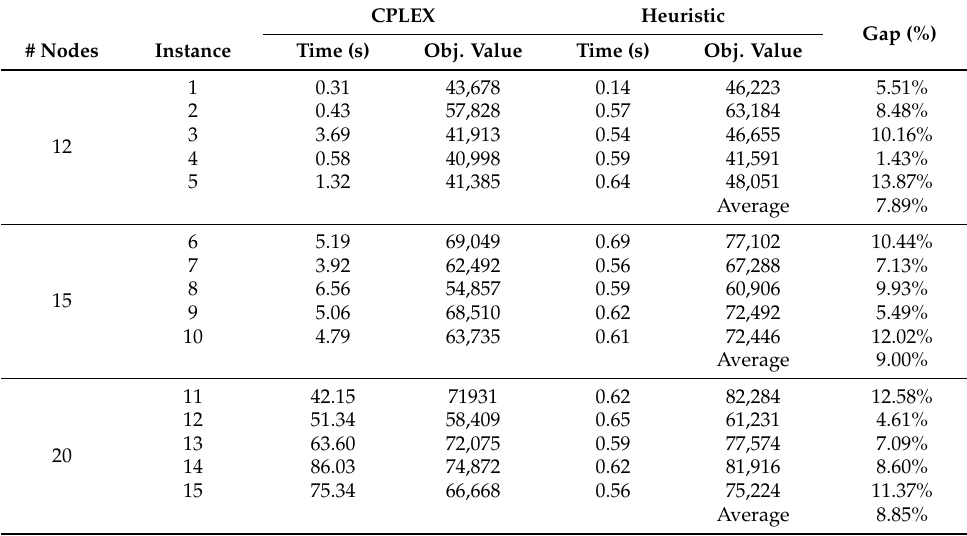
Table 4. Result comparison of the CPLEX and heuristic algorithm.